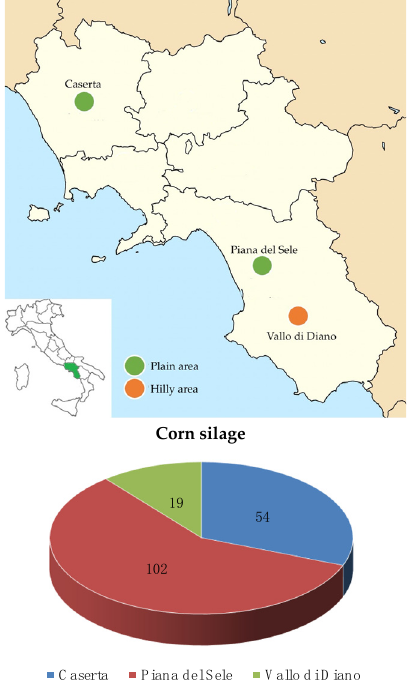
Figure 1. Classification of the silages according to the experimental sites.